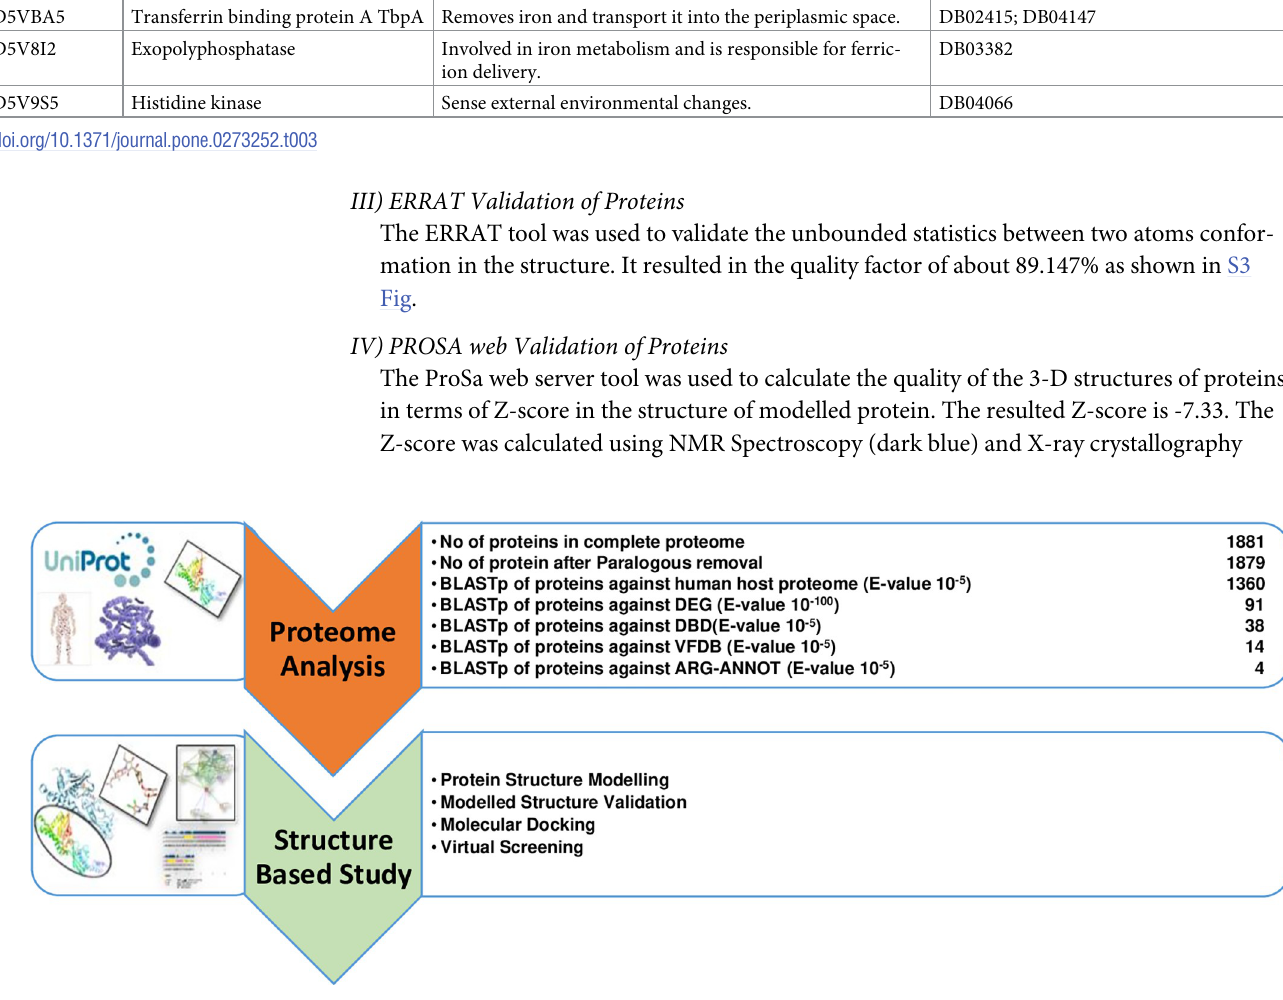
Fig 3. Current study summary for target protein identification: Stepwise analysis of subtractive genomic approach for drug targets identification in M . catarrhalis